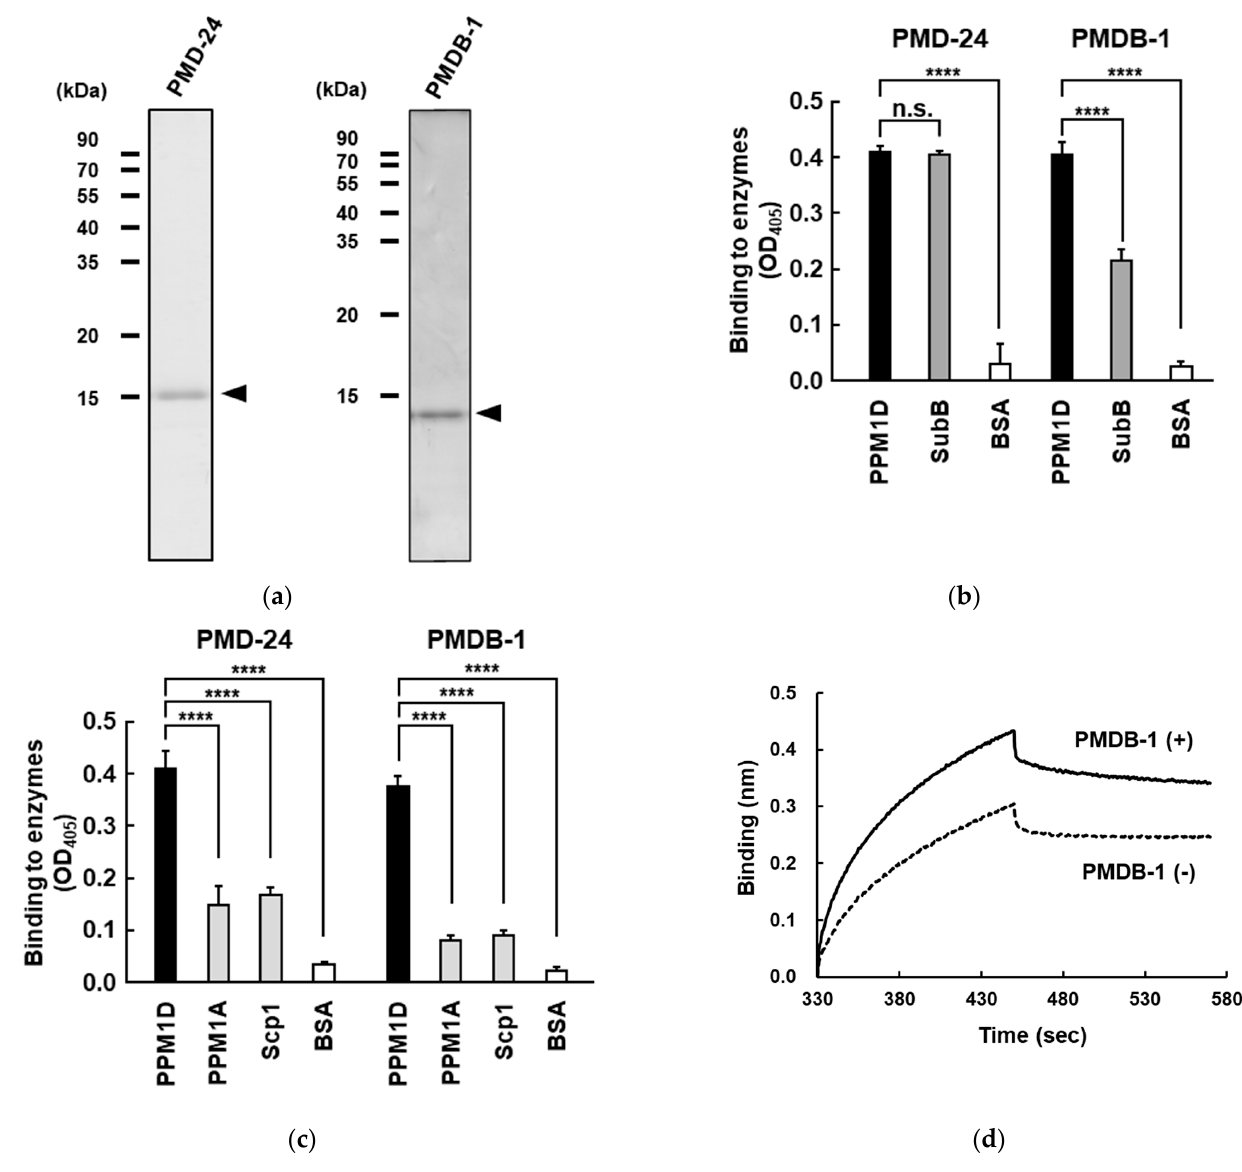
Figure 3. Evaluation of PPM1D binding ability of identified adnectins: ( a ) SDS-PAGE of recombinant proteins of PMD-24 identified against full length PPM1D430 and PMDB-1 identified targeting the B-loop; the recombinant proteins expressed by E. coli system were recovered with high purity (>90%); ( b ) verification of the binding sites of PMD-24 and PMDB-1 recombinant proteins in PPM1D. In the SubB, the B-loop was substituted by the corresponding sequences in the PPM1A protein; ( c ) confirmation of the binding site of PMD-24 and PMDB-1 recombinant proteins in PPM1D. Two kinds of Ser/Thr protein phosphatases, one is PPM1A, a PPM-type Ser/Thr protein phosphatase at the same type of phosphatase with PPM1D, and another is Scp1, a FCP/SCP type Ser/Thr protein phosphatase, were used in the binding assay in addition to PPM1D. ****: p < 0.001; ( d ) binding assays of PMDB-1 to PPM1D by biolayer interferometry. PPM1D430 (300 nM) were measured in the presence (3 µ M) or absence of biotinylated PMDB-1 adnectin in 25 mM HEPES (pH 7.6) buffer with 150 mM NaCl, 30 mM MgCl 2 , and 0.1% BSA. The measurement was performed in the Advanced Kinetics mode of the BLItz system using streptavidin biosensor chips.